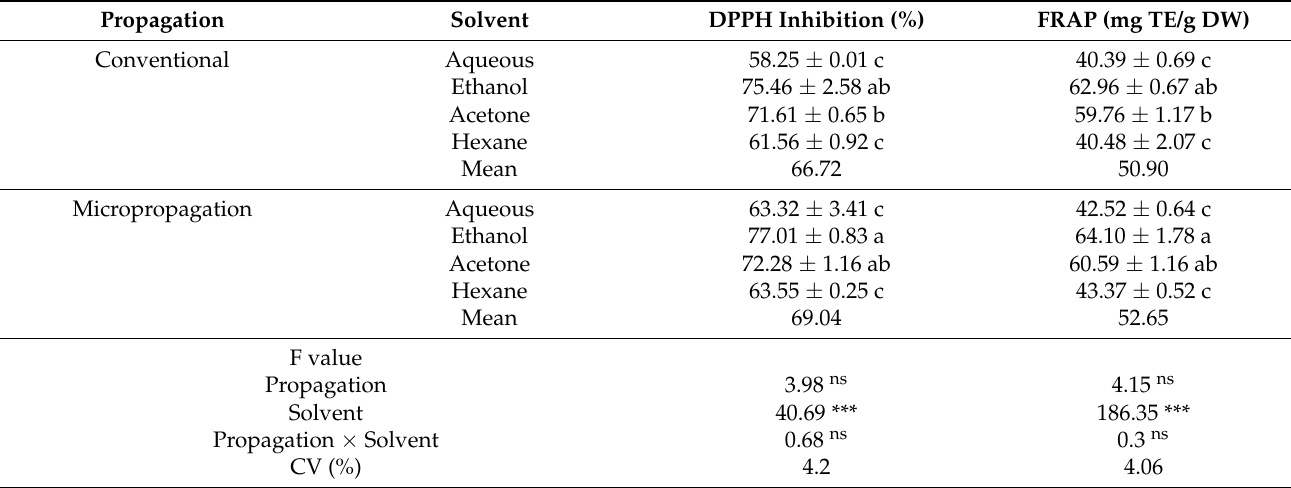
Table 7. 2,2-diphenyl-1-picrylhydrazyl (DPPH) free radical scavenging activity and ferric reducing antioxidant power (FRAP) assay of micropropagated and conventionally propagated rhizomes of ‘Bentong’